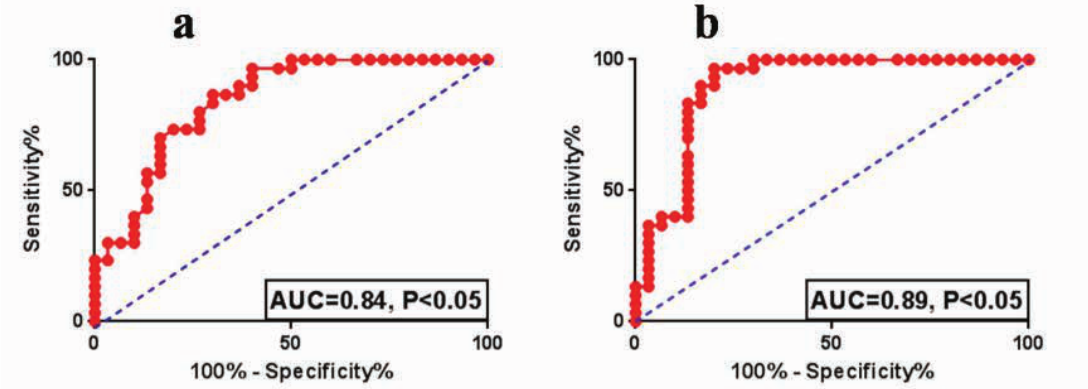
pregnant women whose blood pressure is normal